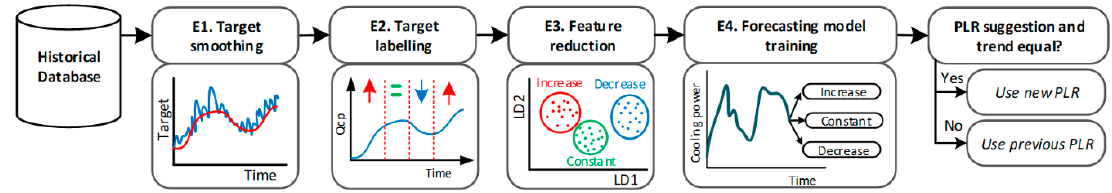
Figure 7. Switching management methodology overview.